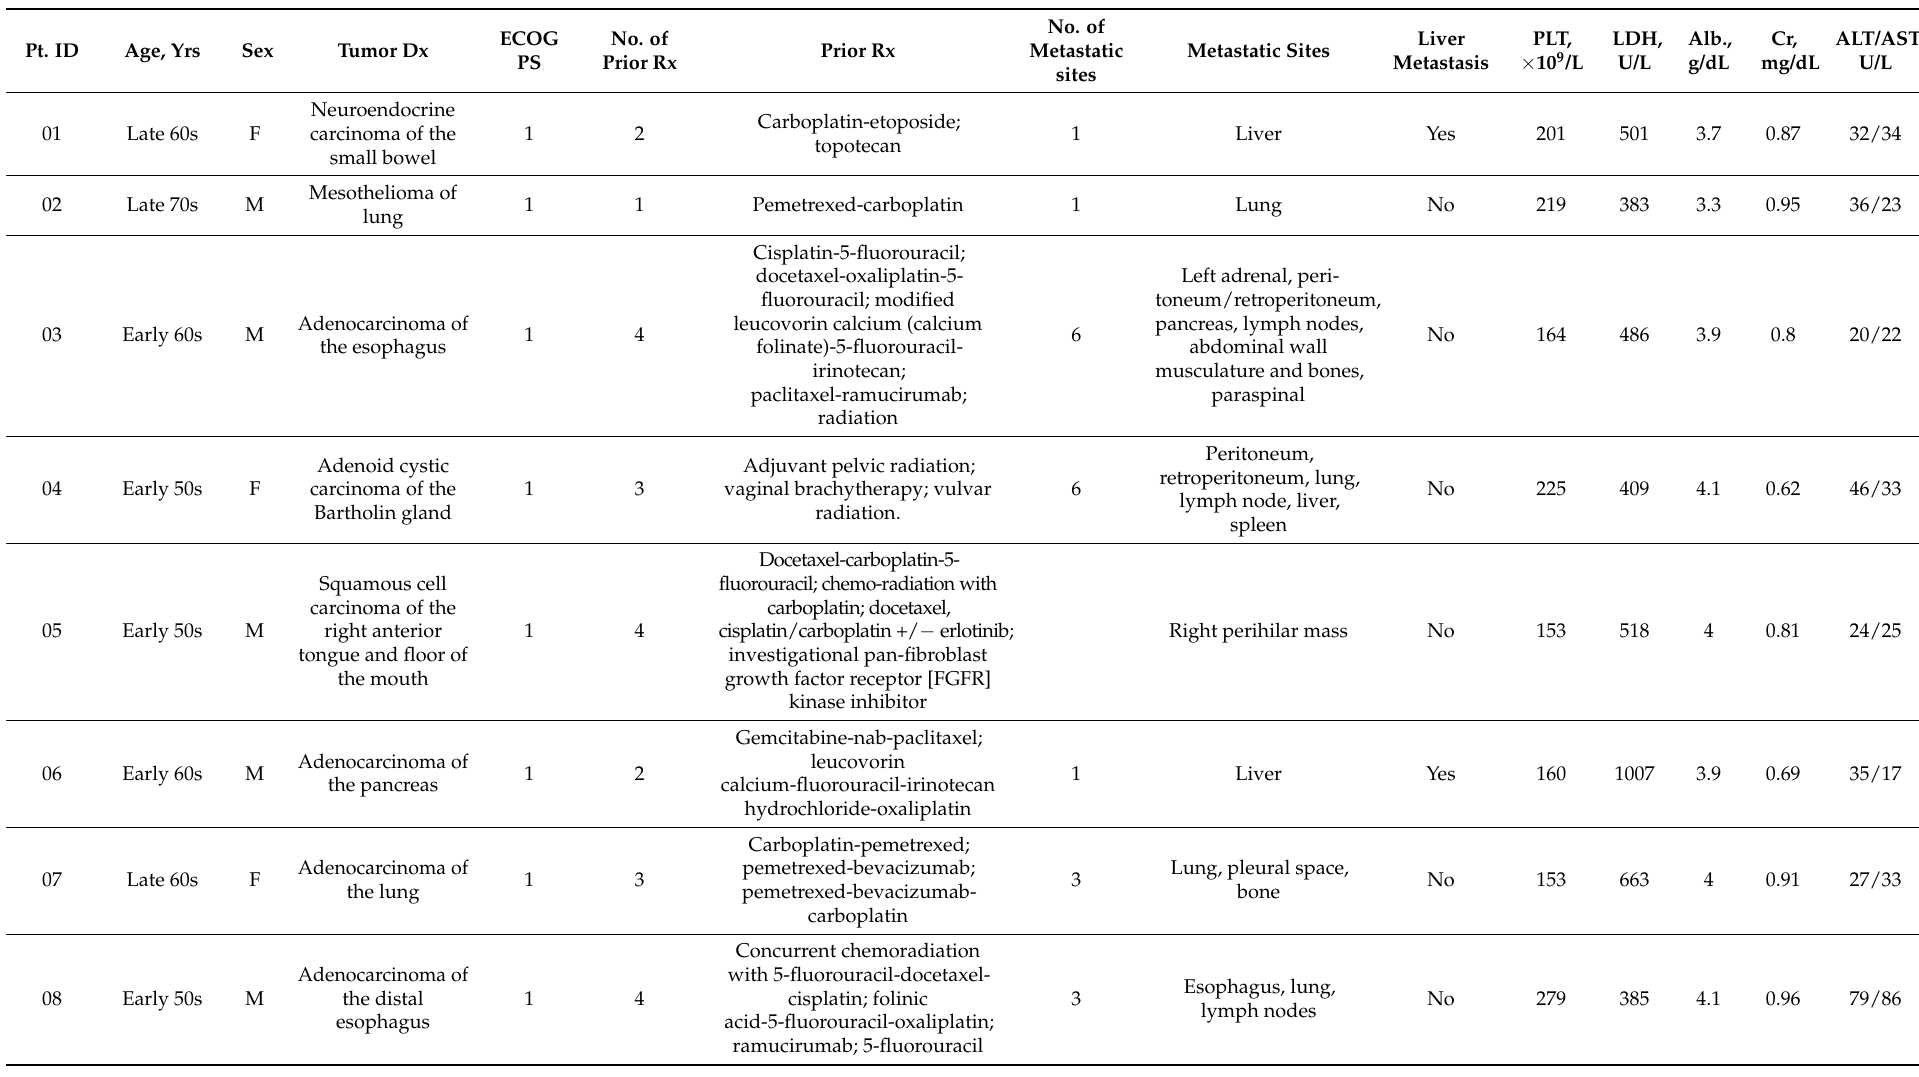
Table 2. Baseline characteristics of 12 patients who underwent treatment with BBI608 and